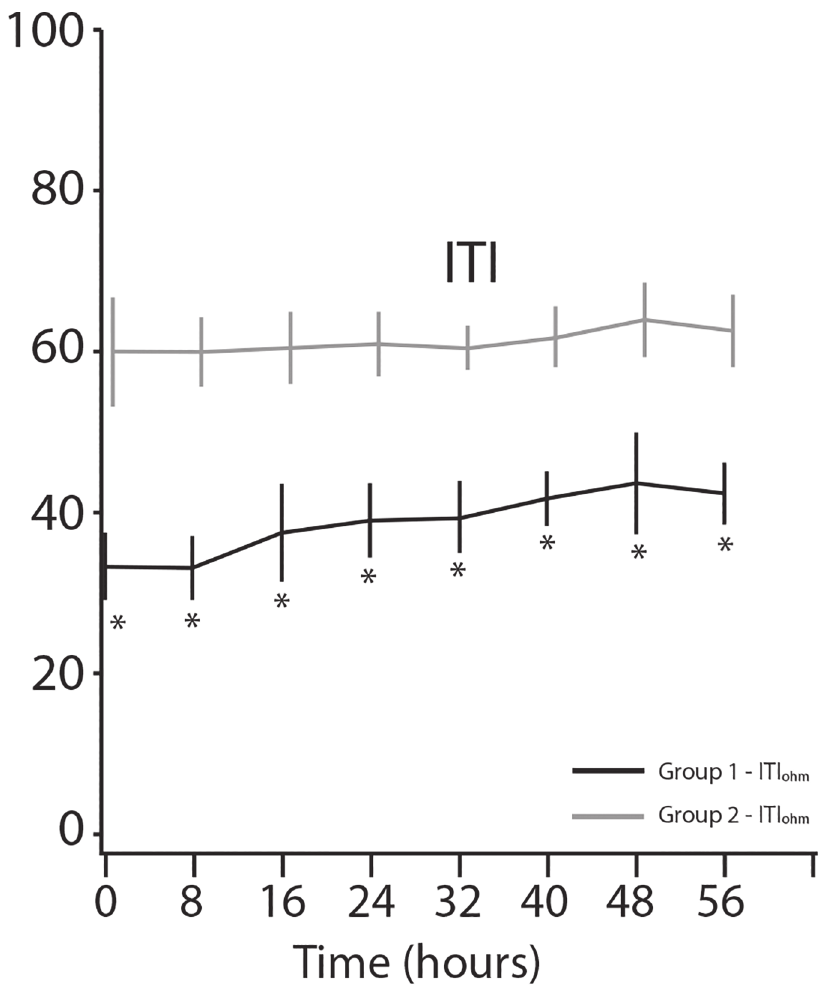
Fig 2. Internal thoracic impedance (ITI) changes over time. * P -value < 0.0001. ** P -value < 0.01. *** P - value =